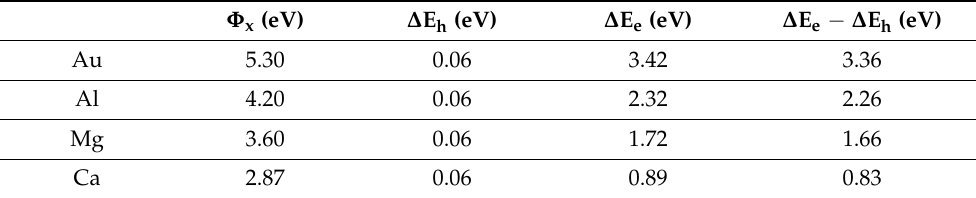
Table 3. Electron/holes injection parameters for PVK-F8T2 application in OLEDs [44,45].